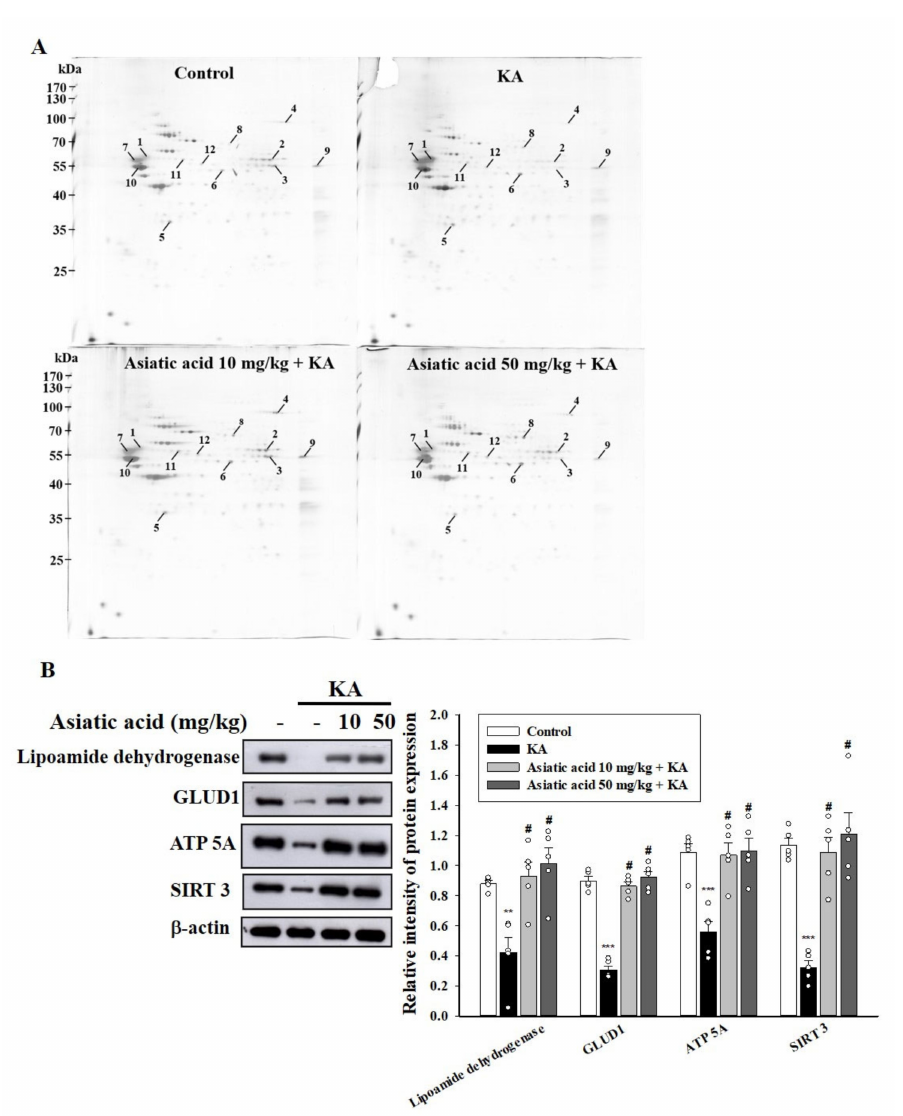
Figure 7. ( A ) Proteomic analysis identified 12 proteins associated with the asiatic acid pretreatment in the hippocampal synaptosomes of rats with KA-induced seizures. Global view of the protein spots on the two-dimensional gels. Protein spots with meaningful changes in intensity are labeled with Arabic numerals. ( B ) Western blot showing the expression levels of lipoamide dehydrogenase, GLUD1 (glutamate dehydrogenase 1), ATP5A (mitochondrial membrane ATP synthase), and SIRT3 (mitochondrial deacetylase sirtuin-3) in the hippocampus for each group. The relative protein levels were quantified. ** p < 0.01, *** p < 0.001 (vs. control); # p < 0.001 (asiatic acid + KA vs. KA); n = 5 rats per